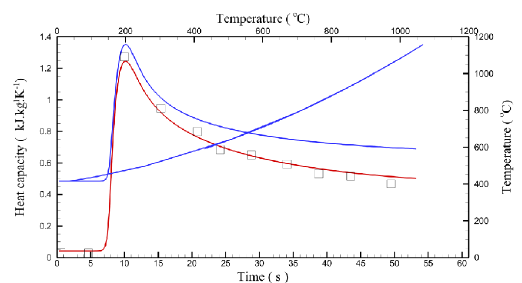
Figure 8. Transient heat capacity calculations at position TP using equation 3 and table 3 (heat input =1.2 kJ mm -1 ).